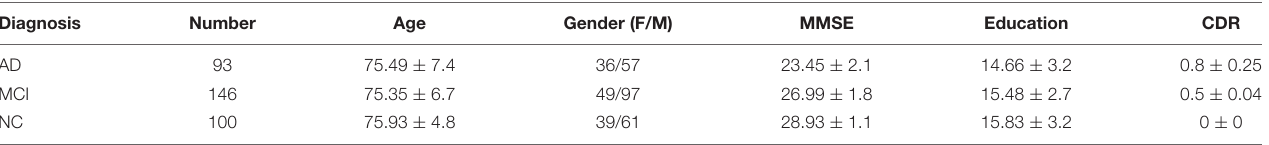
TABLE 1 | Demographic characteristics of the studied subjects (from ADNI database).